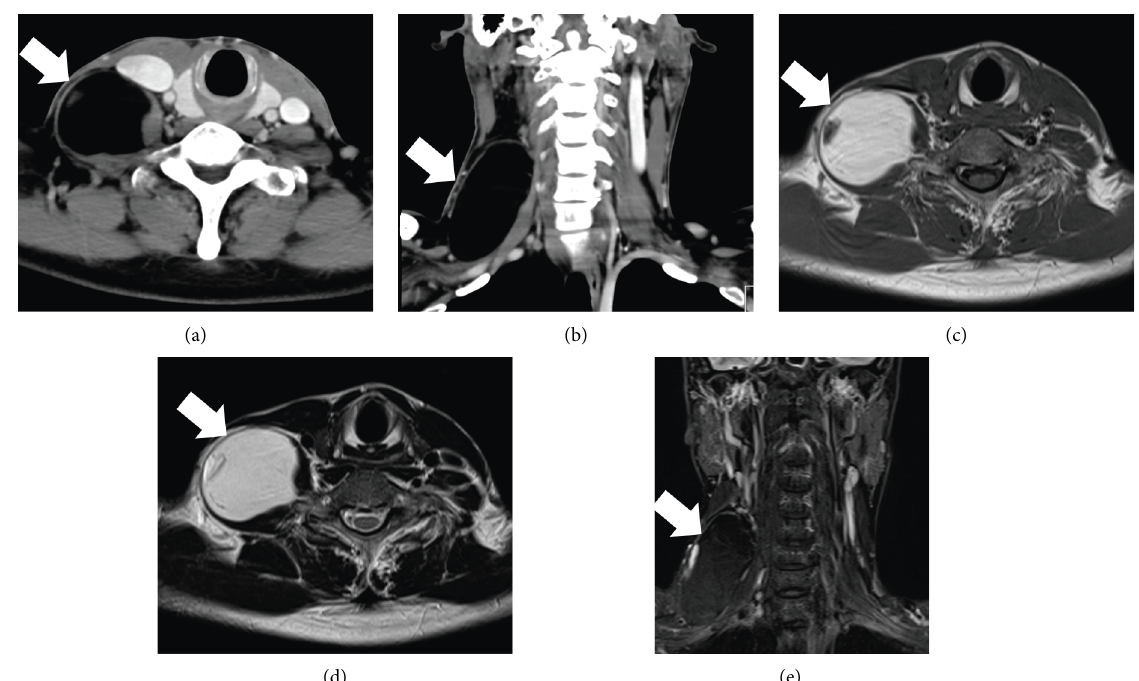
Figure 1: Imaging findings: contrast-enhanced computed tomography ((a) horizontal section and (b) coronal section) showing a well- defined, 85 × 50mm tumor (arrow) in the right neck. There was no contrast effect inside the tumor. Contrast-enhanced MRI ((c) T1- weighted images, (d) T2-weighted images, and (e) STIR) shows the tumor had low signal intensity on T1-weighted images, high signal intensity on T2-weighted images, and low signal intensity on STIR. Variable signal intensity areas were seen outside the tumor.